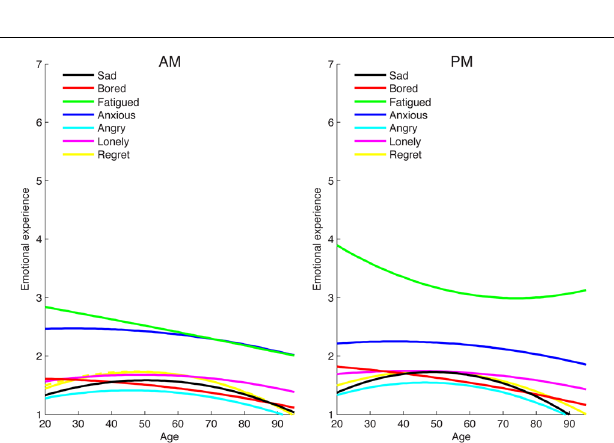
FIGURE 2 | Age differences in negative emotional experience in the morning (AM) and evening (PM).